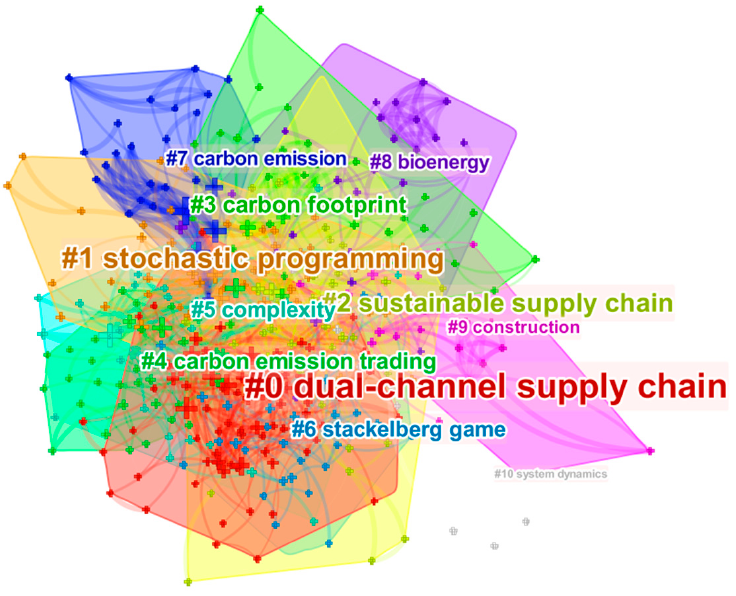
Figure 7. LCSC keyword clustering.